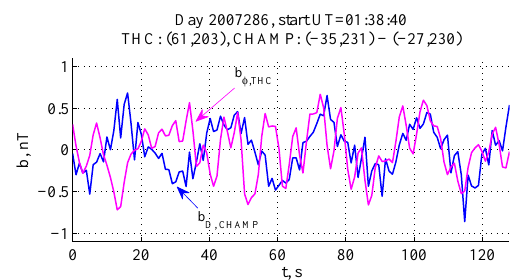
Figure 6. Filtered magnetograms for THEMIS-C ( b ϕ ) and CHAMP ( b D ) components for the 128s interval starting at 01:38:40UT on day 2007286. Average latitude and longitude values in CGM coor- dinates of the northern magnetic field line footprint of THEMIS-C’s location during the interval shown are given in the figure title.